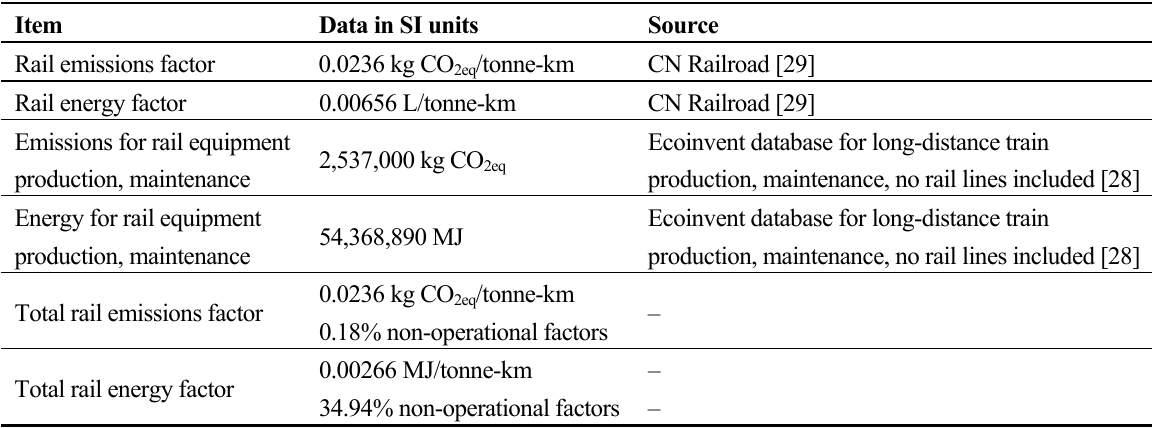
Table 5. Data and assumptions for rail